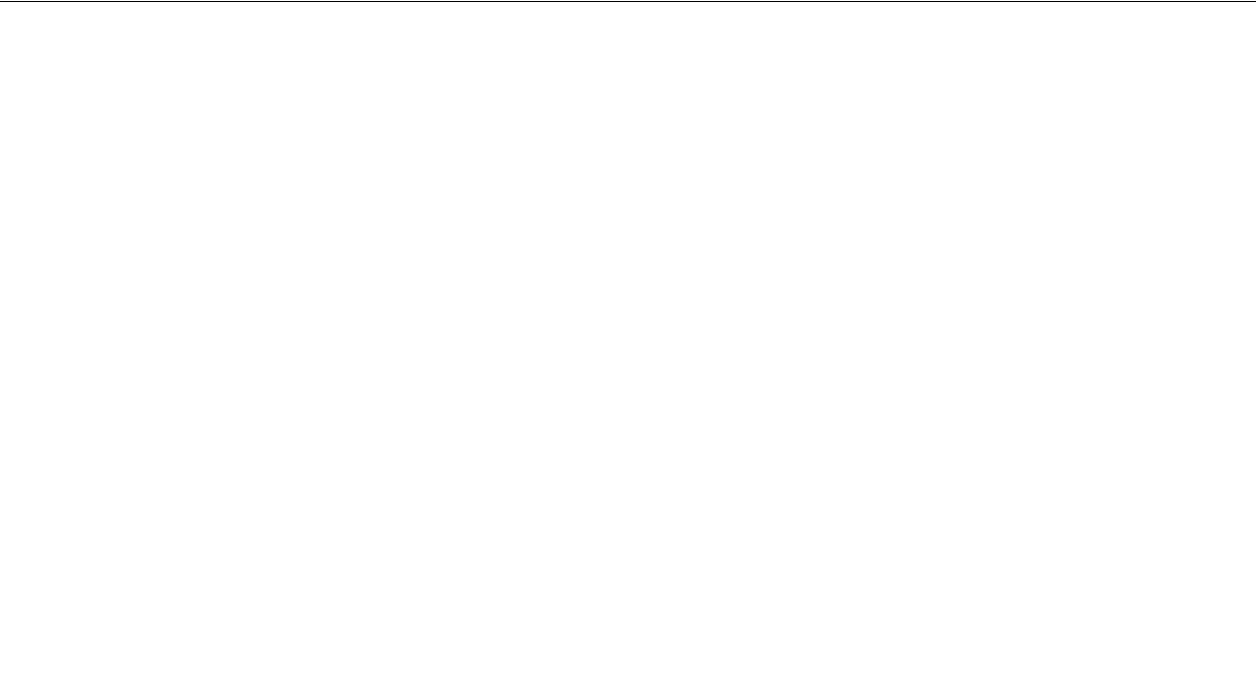
Frontiers in Pharmacology |